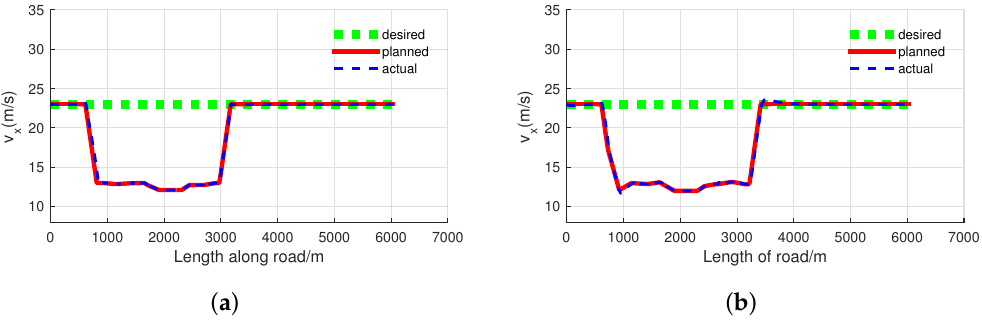
Figure 29. Speed plans: ( a ) Controller A + ISPFCE and ( b ) Controller B + ISPFCE.